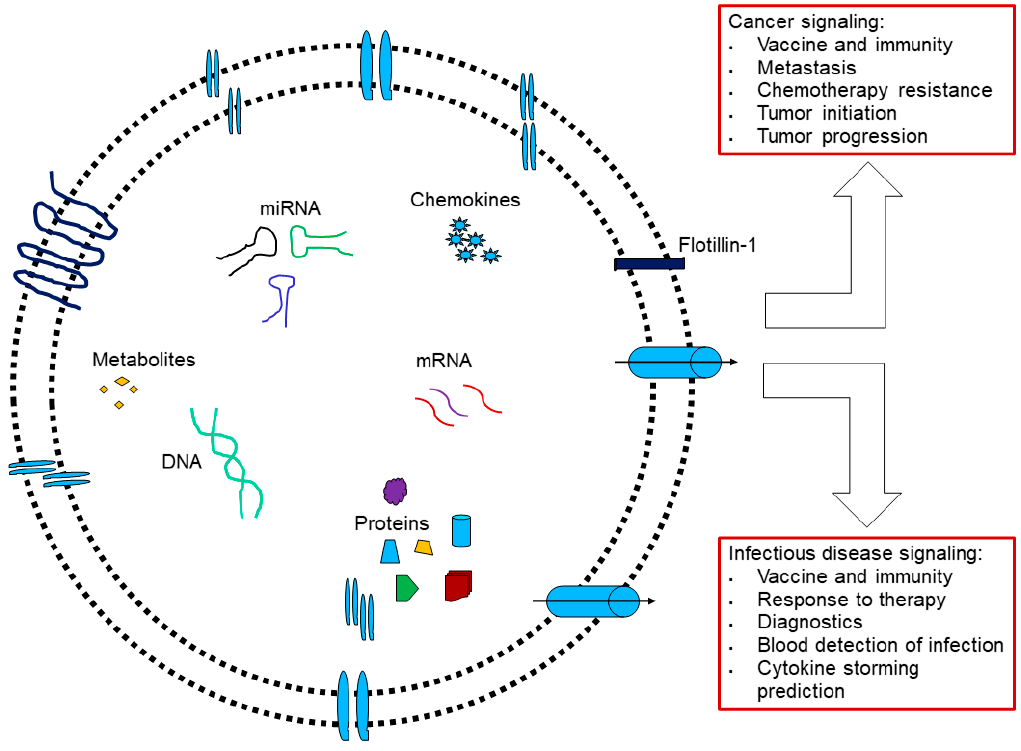
Figure 3. Extracellular vesicles are involved in cancer and infectious diseases. (Adapted from [42]).